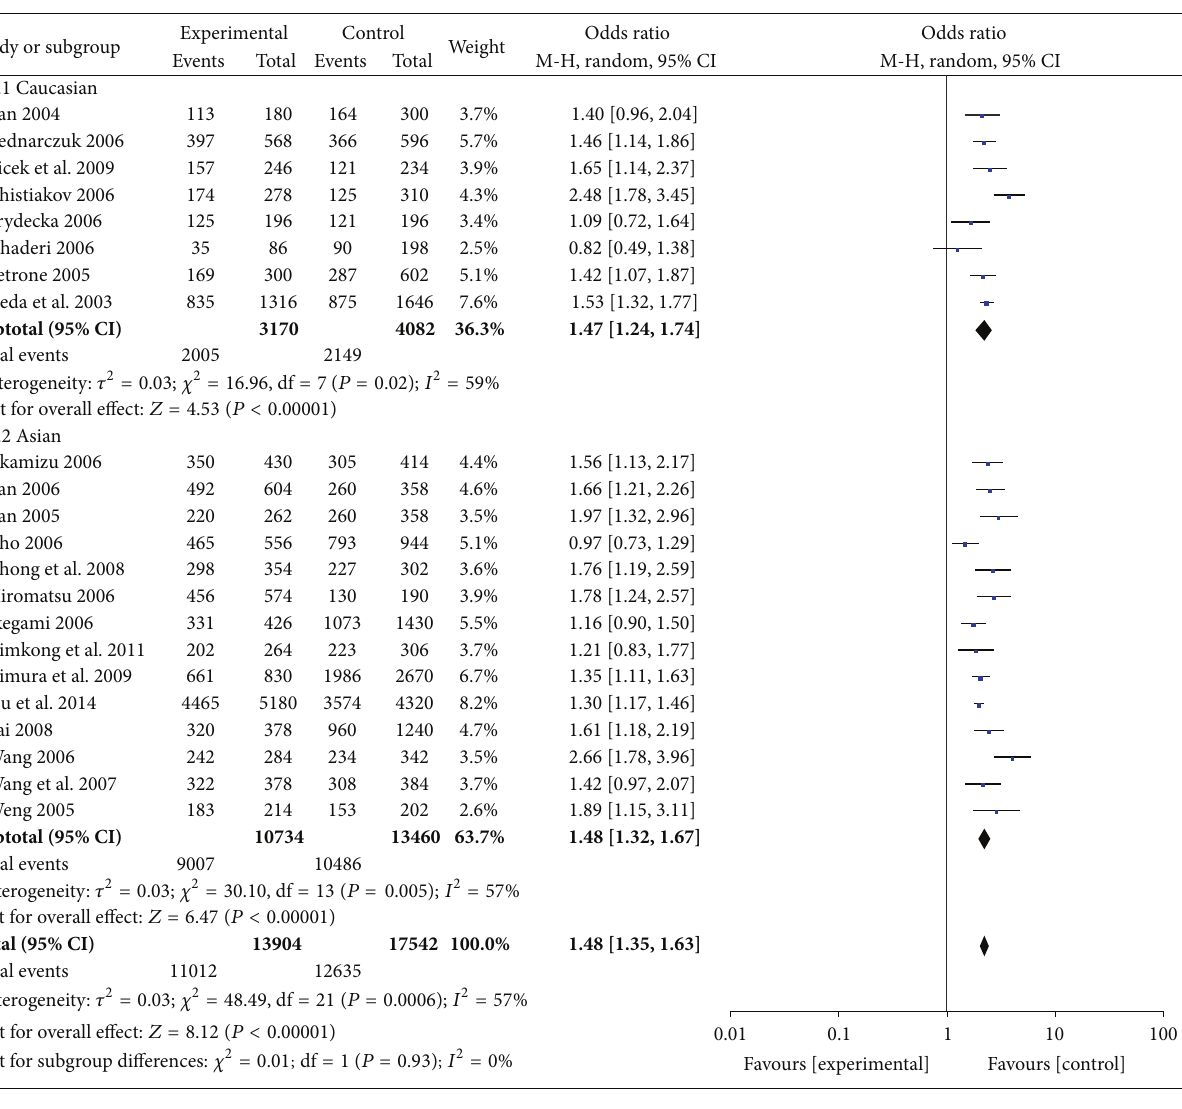
Figure 4: Forest plot of the association between an allele model of CT60 polymorphism and